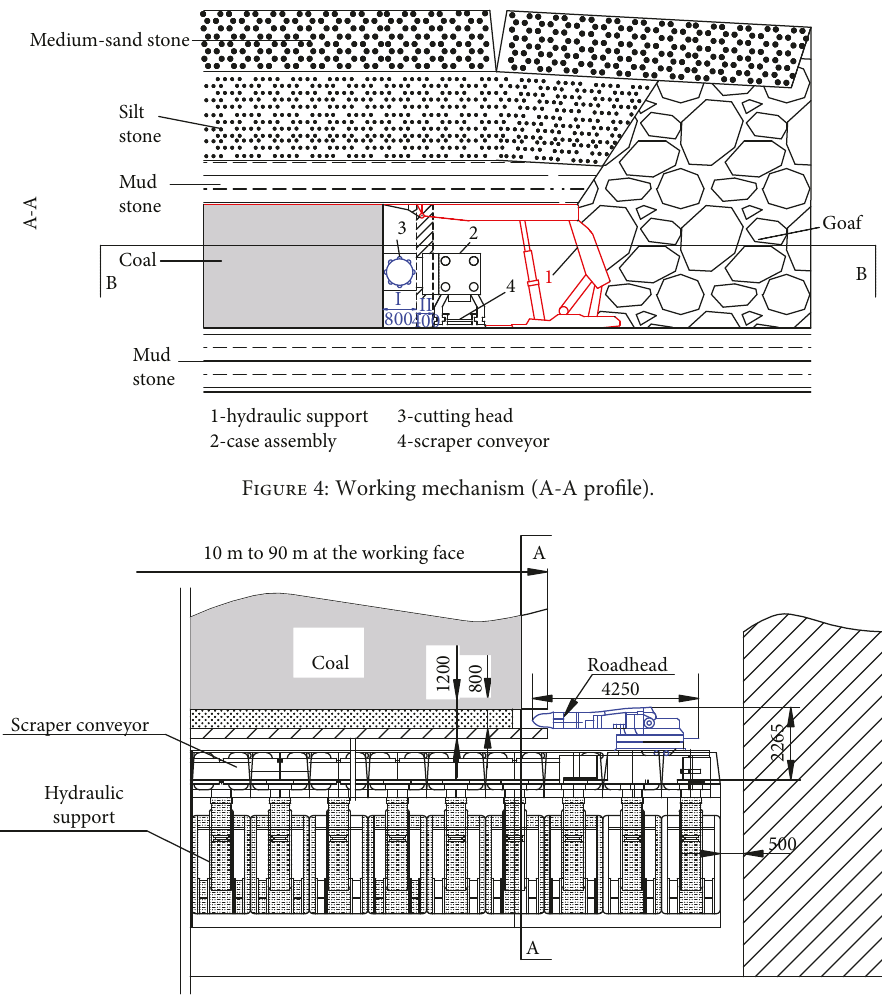
Figure 5: The fi eld layout of the CISOM method.